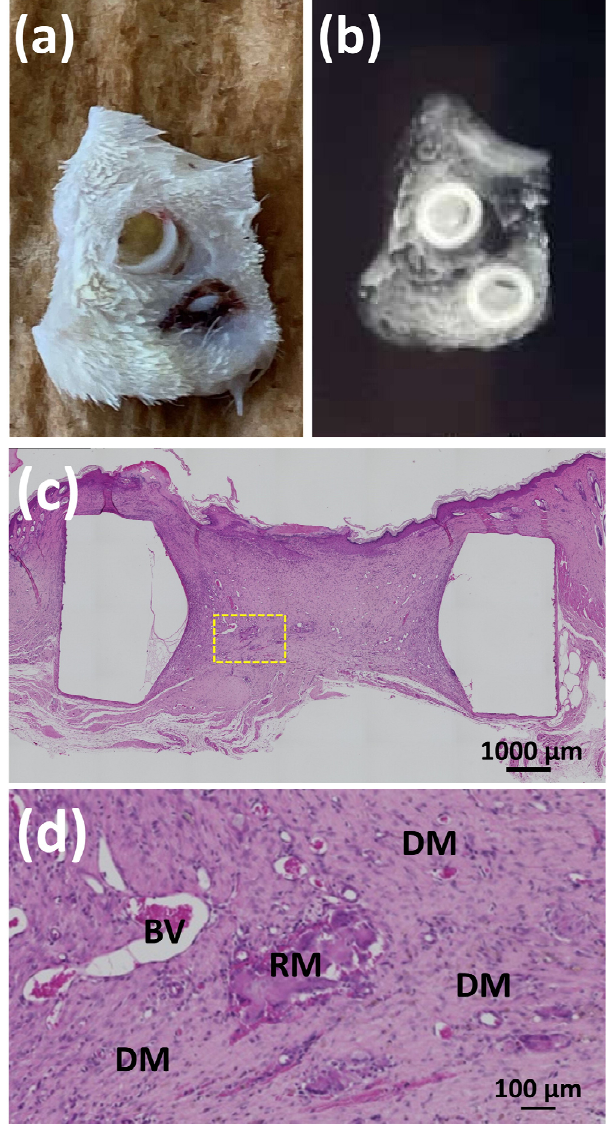
Figure 17. ( a , b ) Photograph of the skin of a rat with control II gels (SG II*BMP ( − )) in two Teflon rings after 8 weeks of placement and the corresponding soft X-ray image, respectively; ( c ) low-mag- nification HE-stained image of the interior of the Teflon ring 8 weeks after the placement of control gel II (SG II*BMP ( − )); and ( d ) magnified HE-stained image of the yellow-dotted rectangle in Figure 17c. Note: RM, residual material; DM, dermal tissues; BV, blood vessels.